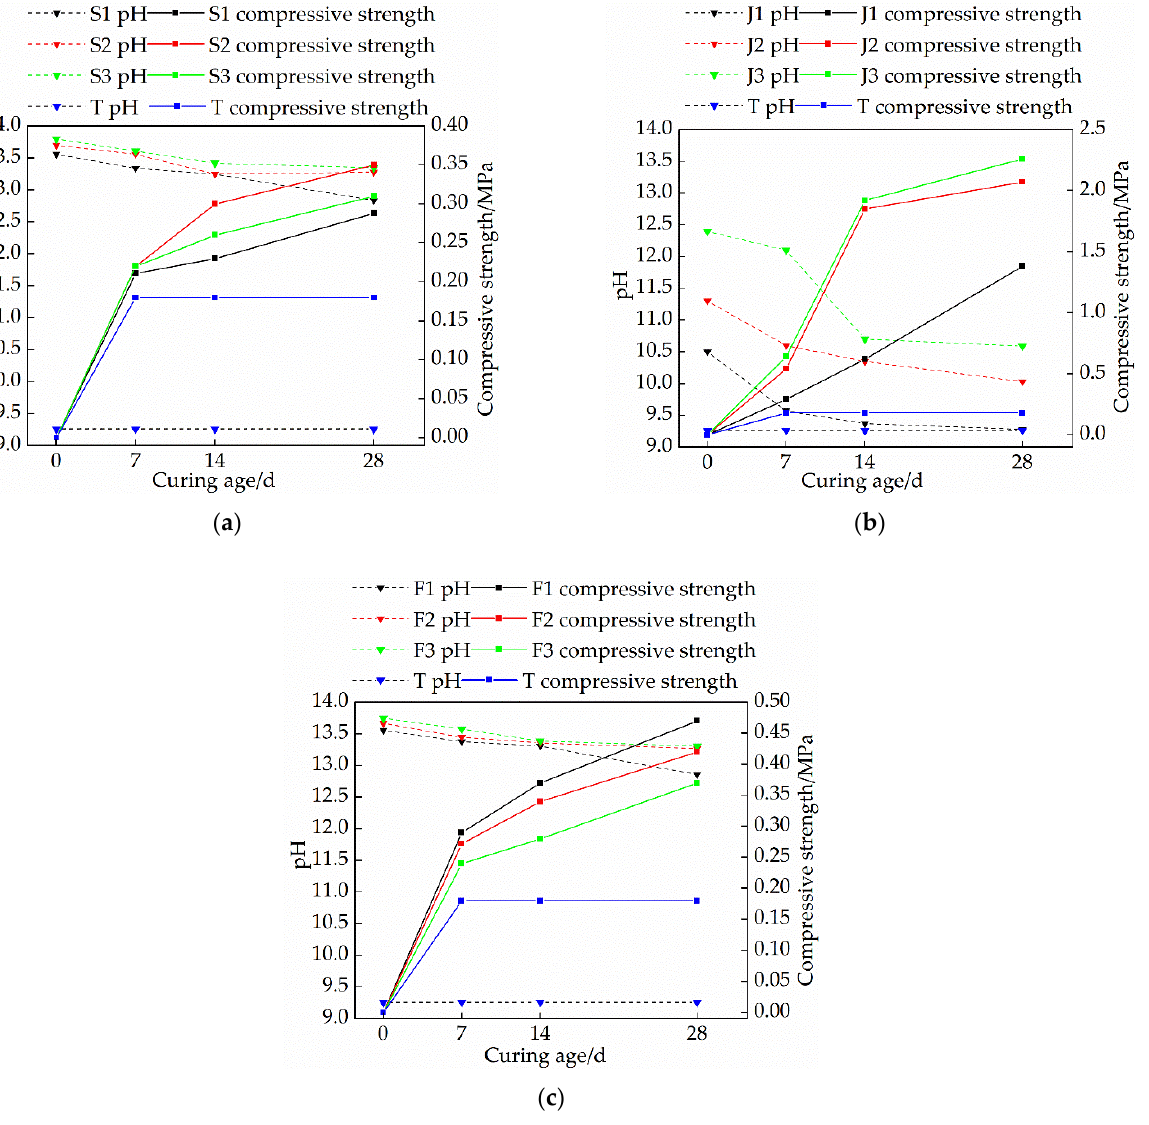
Figure 6. The relationship between compressive strength, pH, and curing age: ( a ) Single mixed quicklime group; ( b ) Mono-doped sodium methyl silicate group; ( c ) Compounding group .